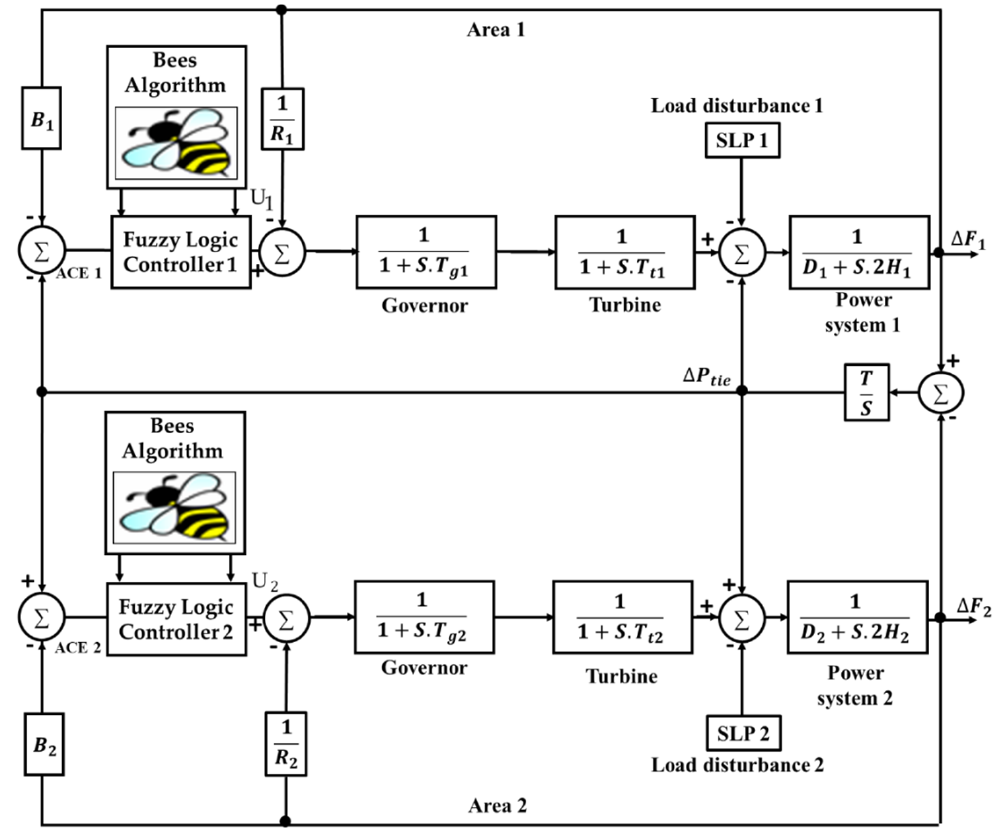
Figure 1. Transfer function model of the testbed system. Table 1. The parameters of the testbed